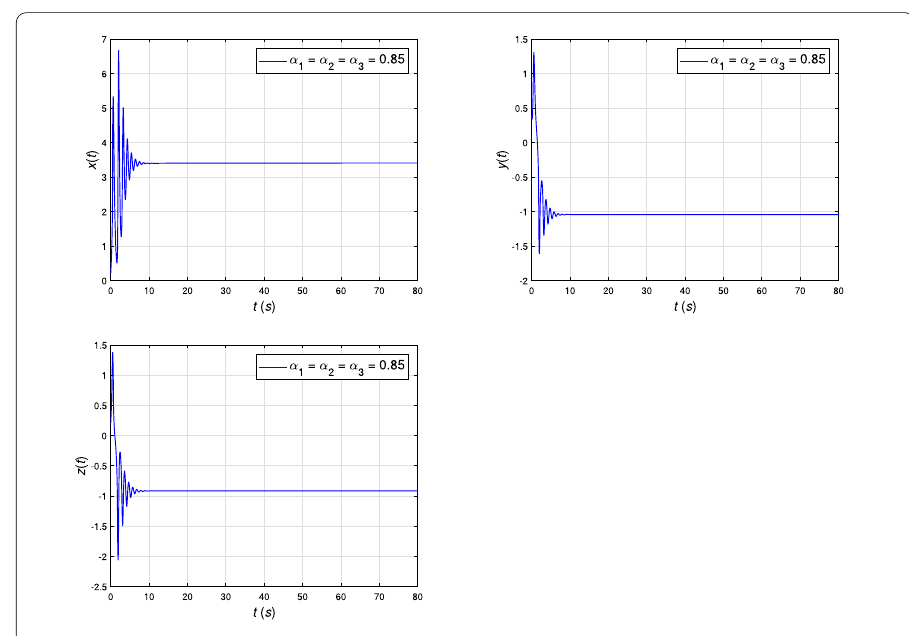
Figure 1 State variables of the fractional-order model (21) in the time-domain ( α i = 0.85, i = 1,2,3)